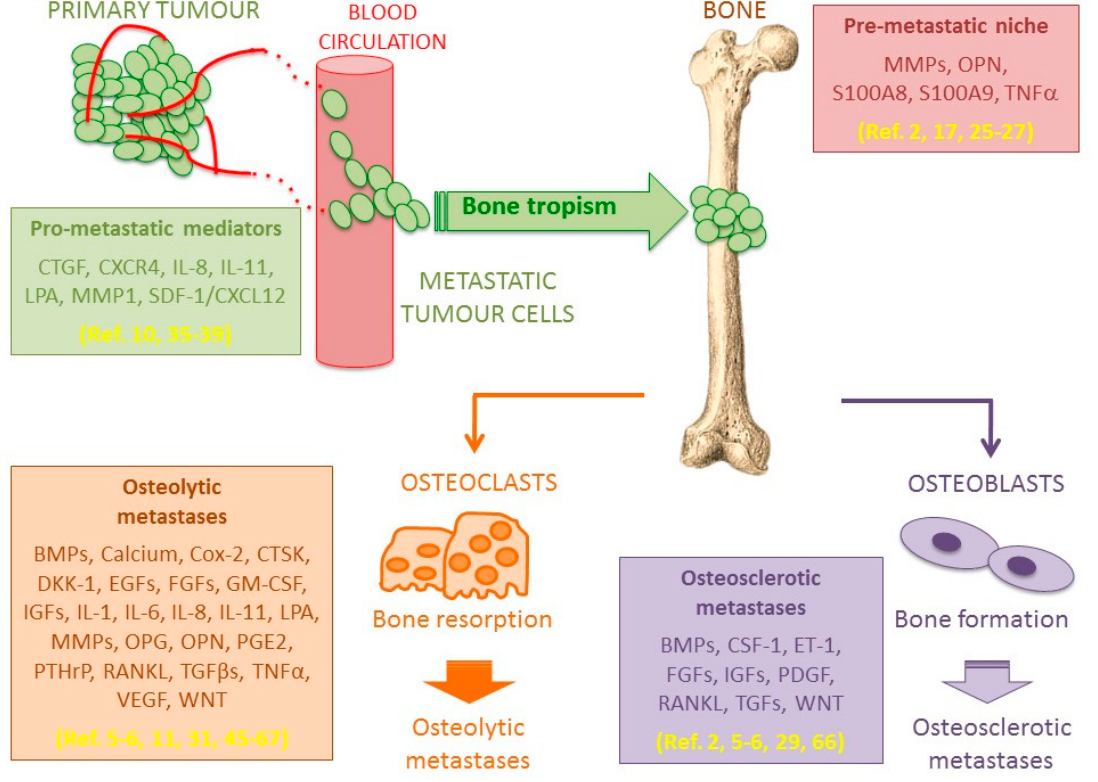
Figure 1. Factors involved in hematogen dissemination and tissue invasion by cancer cells with a bone tropism. Factors involved in bone metastatic progression are mainly related to (i) migration of metastatic tumour cells within blood circulation, (ii) invasion of bone marrow niche, and (iii) development within bone tissue through two mechanisms leading to osteolytic or osteosclerotic lesions, both leading to severe skeletal-related events.